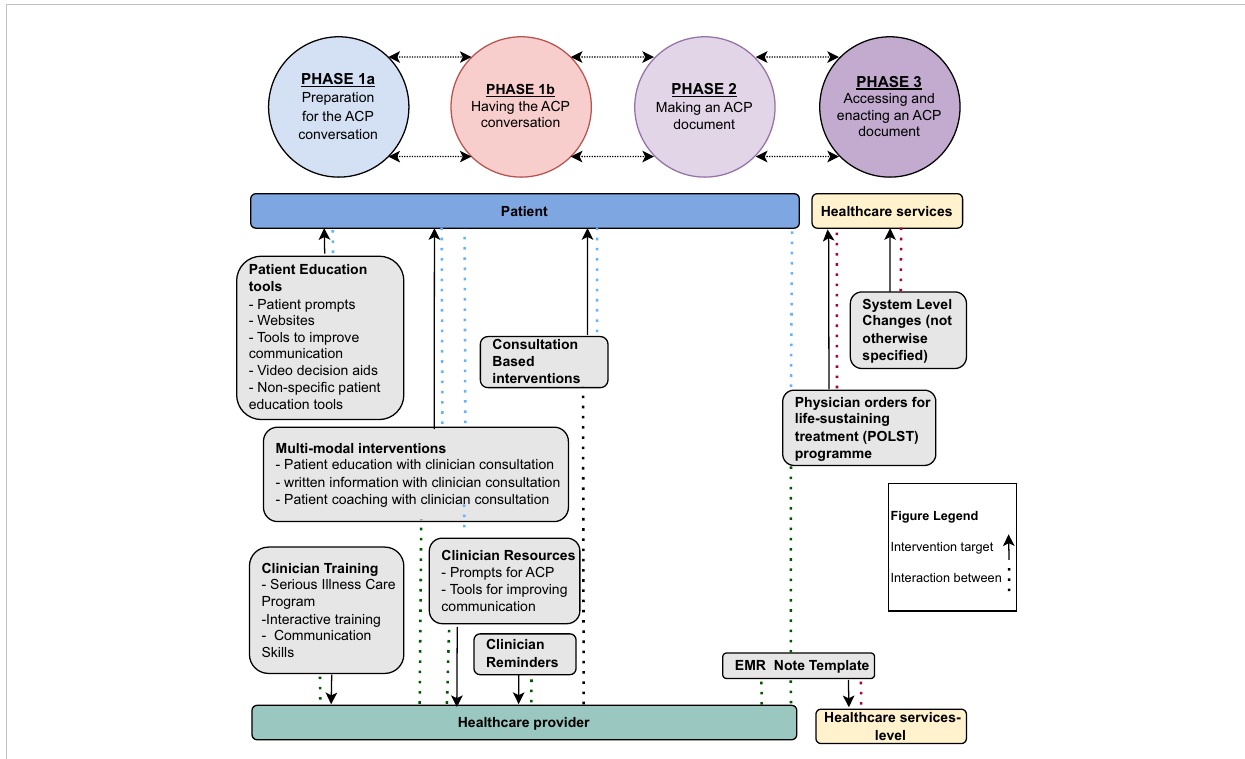
FIGURE 3 Mapping of ACP interventions to the Australian National Framework for ACP